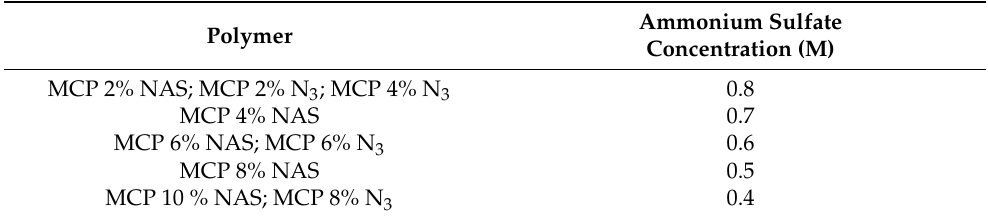
Table 1. Molar concentration of ammonium sulfate used to obtain optimal polymer coating solution depending on the concentration of NAS and azide